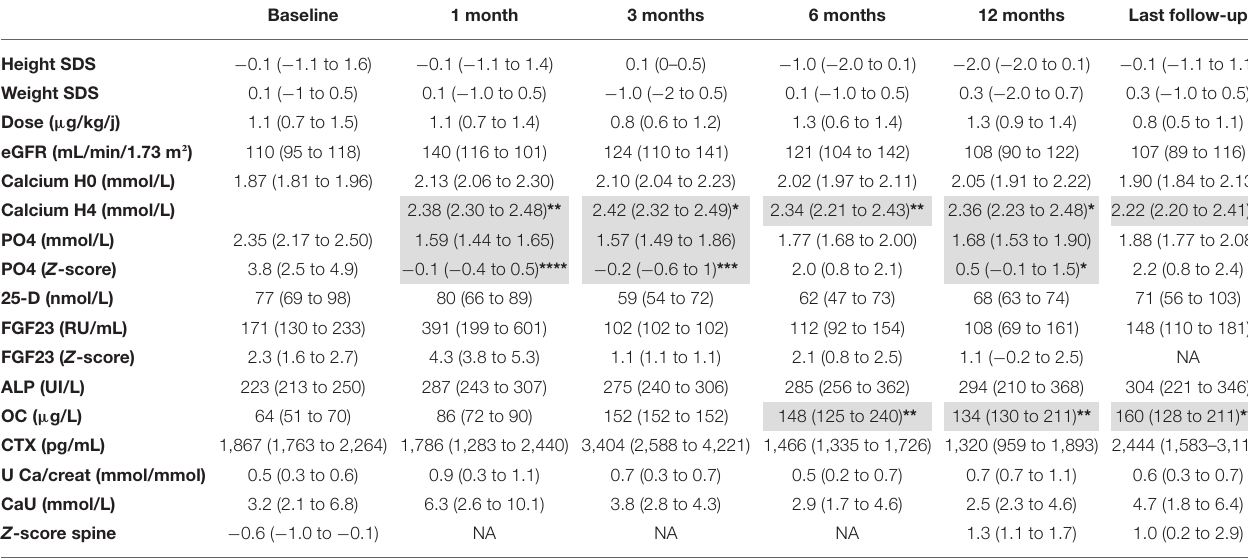
TABLE 3 | Summary of the biomarkers available in patients at the different follow-up. Baseline 1 month